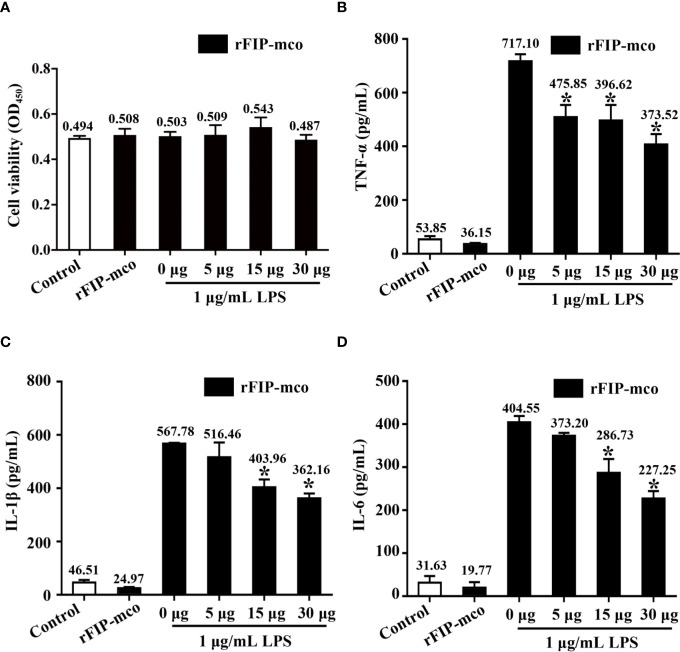
Effects of rFIP-mco on inflammatory cytokines in LPS treated THP-1 cells. Cells were stimulated with LPS (1 μg/ml) for 24 h, and then were treated with gradient concentration of rFIP-mco for 24 h. (A) Cell viability of the THP-1 cells were determined. (B) TNF-α, (C) IL-1β, and (D) IL-6 releases were analyzed by ELISA. *P < 0.05 vs. control groups (untreated cells).